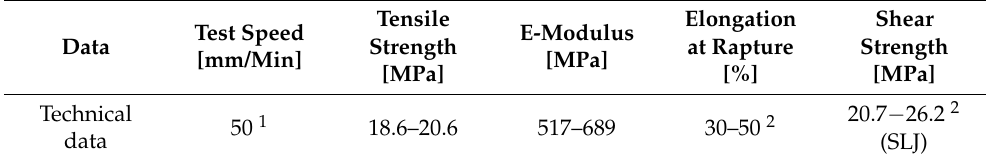
Table 3. Tensile and shear properties of